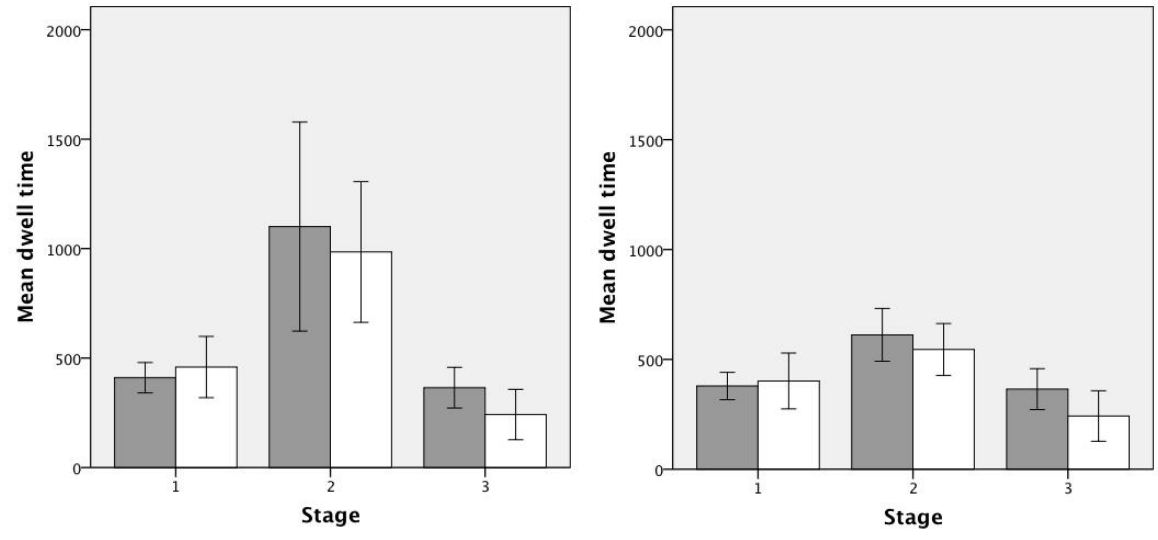
Figure 5. Mean dwell time, the Natural Decision Segmentation Model on the left, Russo and Leclerc (1994) version on the right. Grey bars represent decision task and white bars represent search task. Error bars +/- 2 SE.